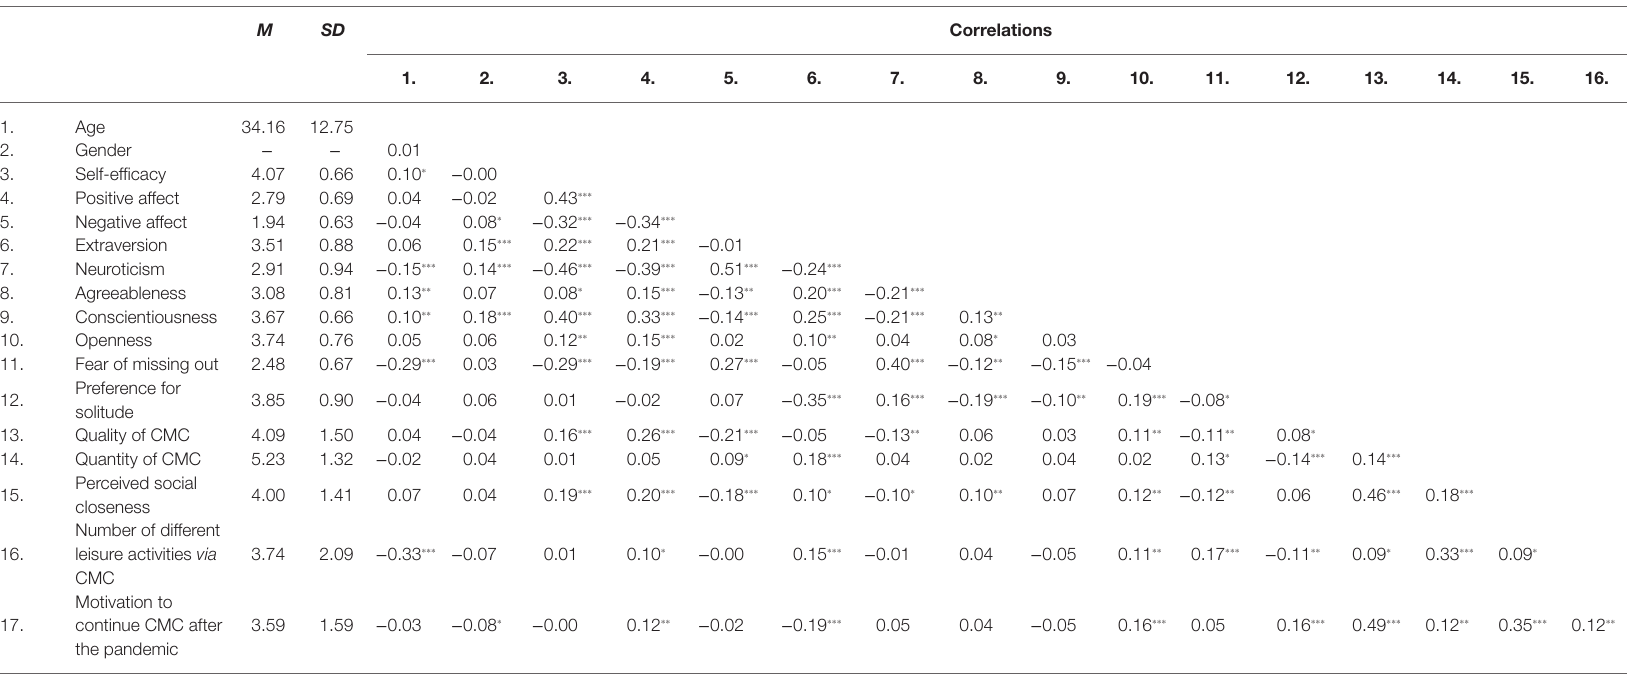
TABLE 1 | Descriptive statistics and bivariate correlations (Pearson r and two-tailed p -value) among all variables included in regression